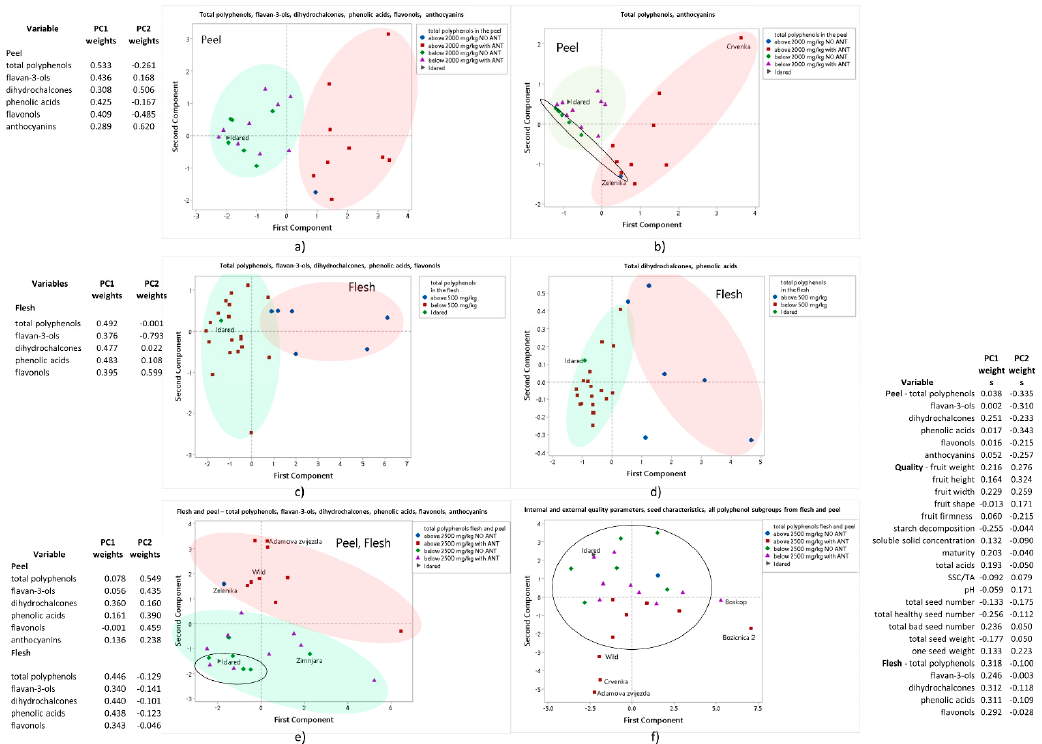
Figure 3. Principal component analysis of ( a ) the amounts of all polyphenol subgroups in the peel, ( b ) the amount of total polyphenols and total anthocyanins in the peel, ( c ) the amount of all polyphenol subgroups in the flesh, ( d ) the amount of total phenolic acids and total dihydrochalcones in the flesh, ( e ) the amount of total polyphenols of all subgroups in the flesh and peel, ( f ) all external and internal quality traits, all seed characteristics, the amount of all polyphenol subgroups in the flesh and peel. NO ANT—apples with no anthocyanins in the peel, WITH ANT—apples with anthocyanins in the peel. Values for principal component 1 and 2 were also shown.